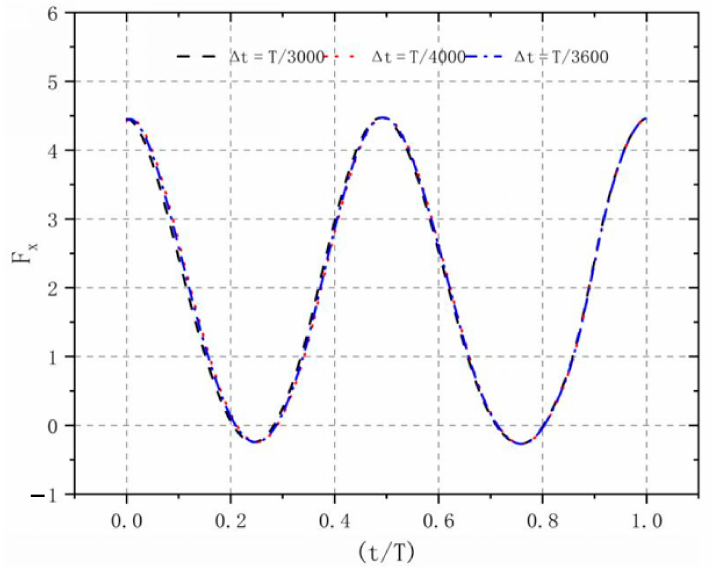
Figure 6. θ 0 = 10 ◦ , h 0 = 0.5c thrust variation diagram at different time